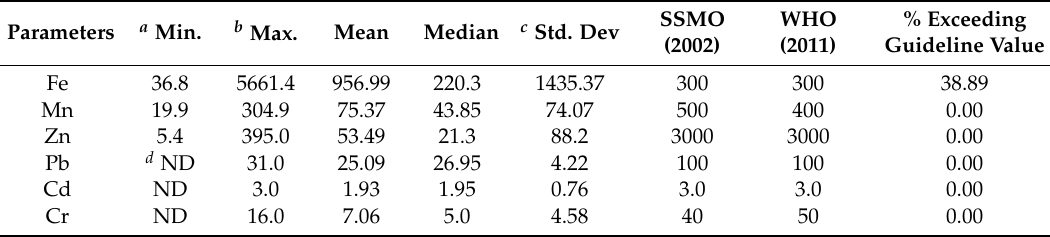
Table 3. Descriptive statistics of heavy metal ions in the groundwater samples and their comparison with SSMO (2002) and WHO (2011) guideline values for drinking water. Parameters a Min.